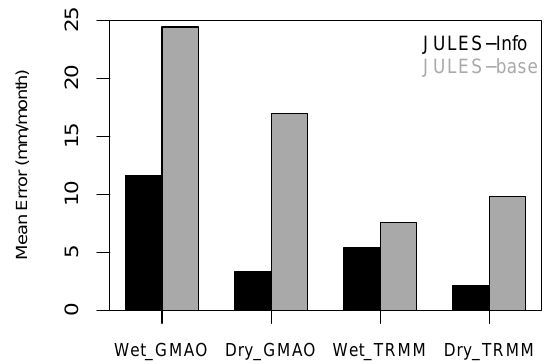
Figure 11. Mean error showing the discrepancy between both ver- sions of JULES and MODIS ET.